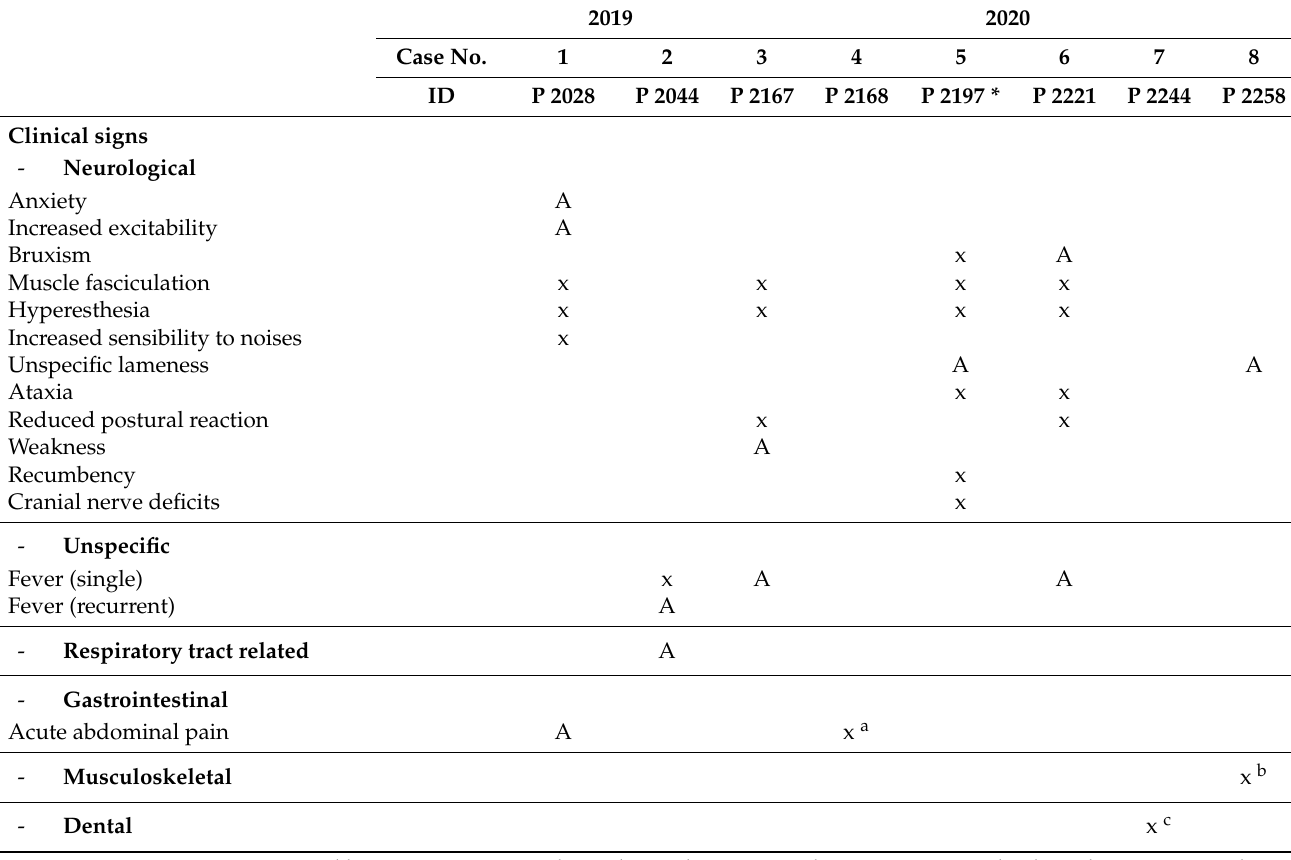
Table 4. Summary of observed clinical signs during the hospitalization period of WNV IgM ELISA- positive horses from panel A (BE/BB), presentation of the relevant clinical signs similar to [22].